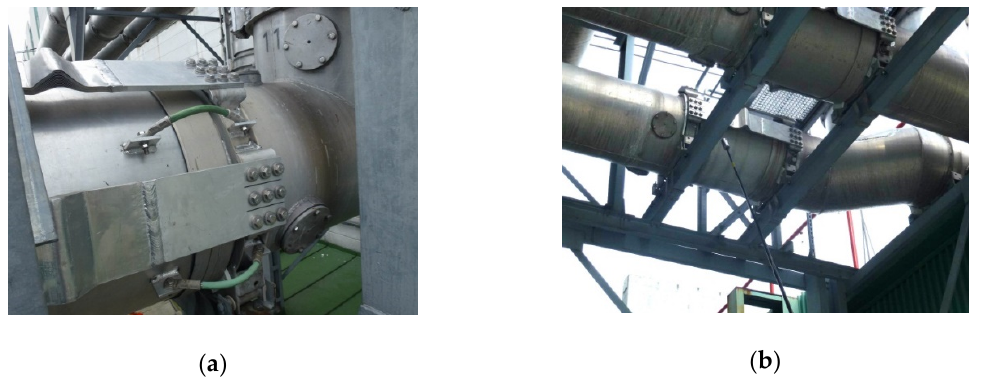
Figure 15. The extendable junction on the feeding bushing for dilatation compensation ( a ); the discharge activity signals close to the bushing dilatation junction examined with a UHF probe ( b ).